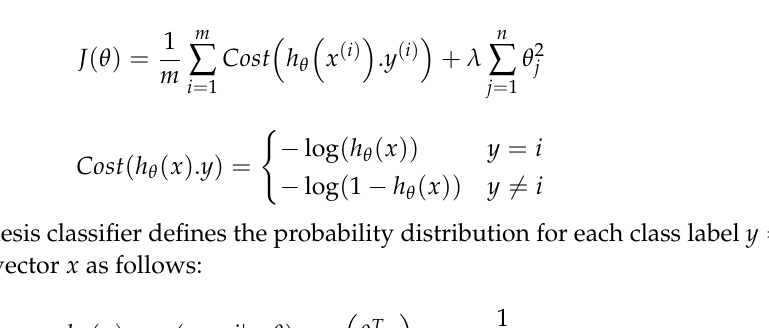
Figure 2. Flowchart of the regularized logistic regression.